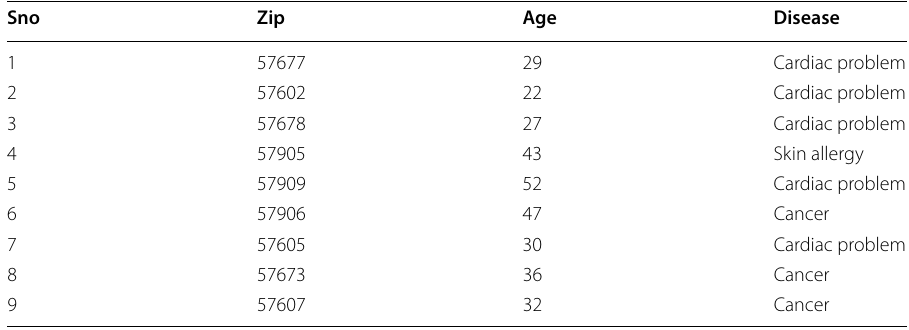
Table 1 Patient data, before